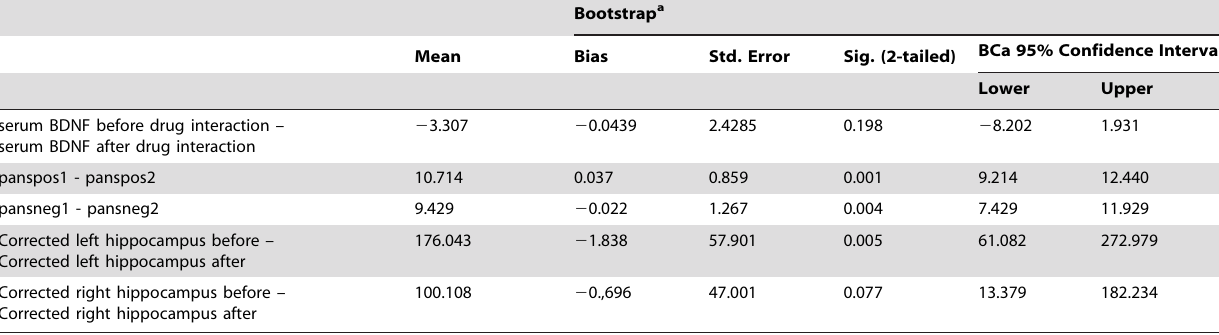
Bootstrap for Paired Samples Test